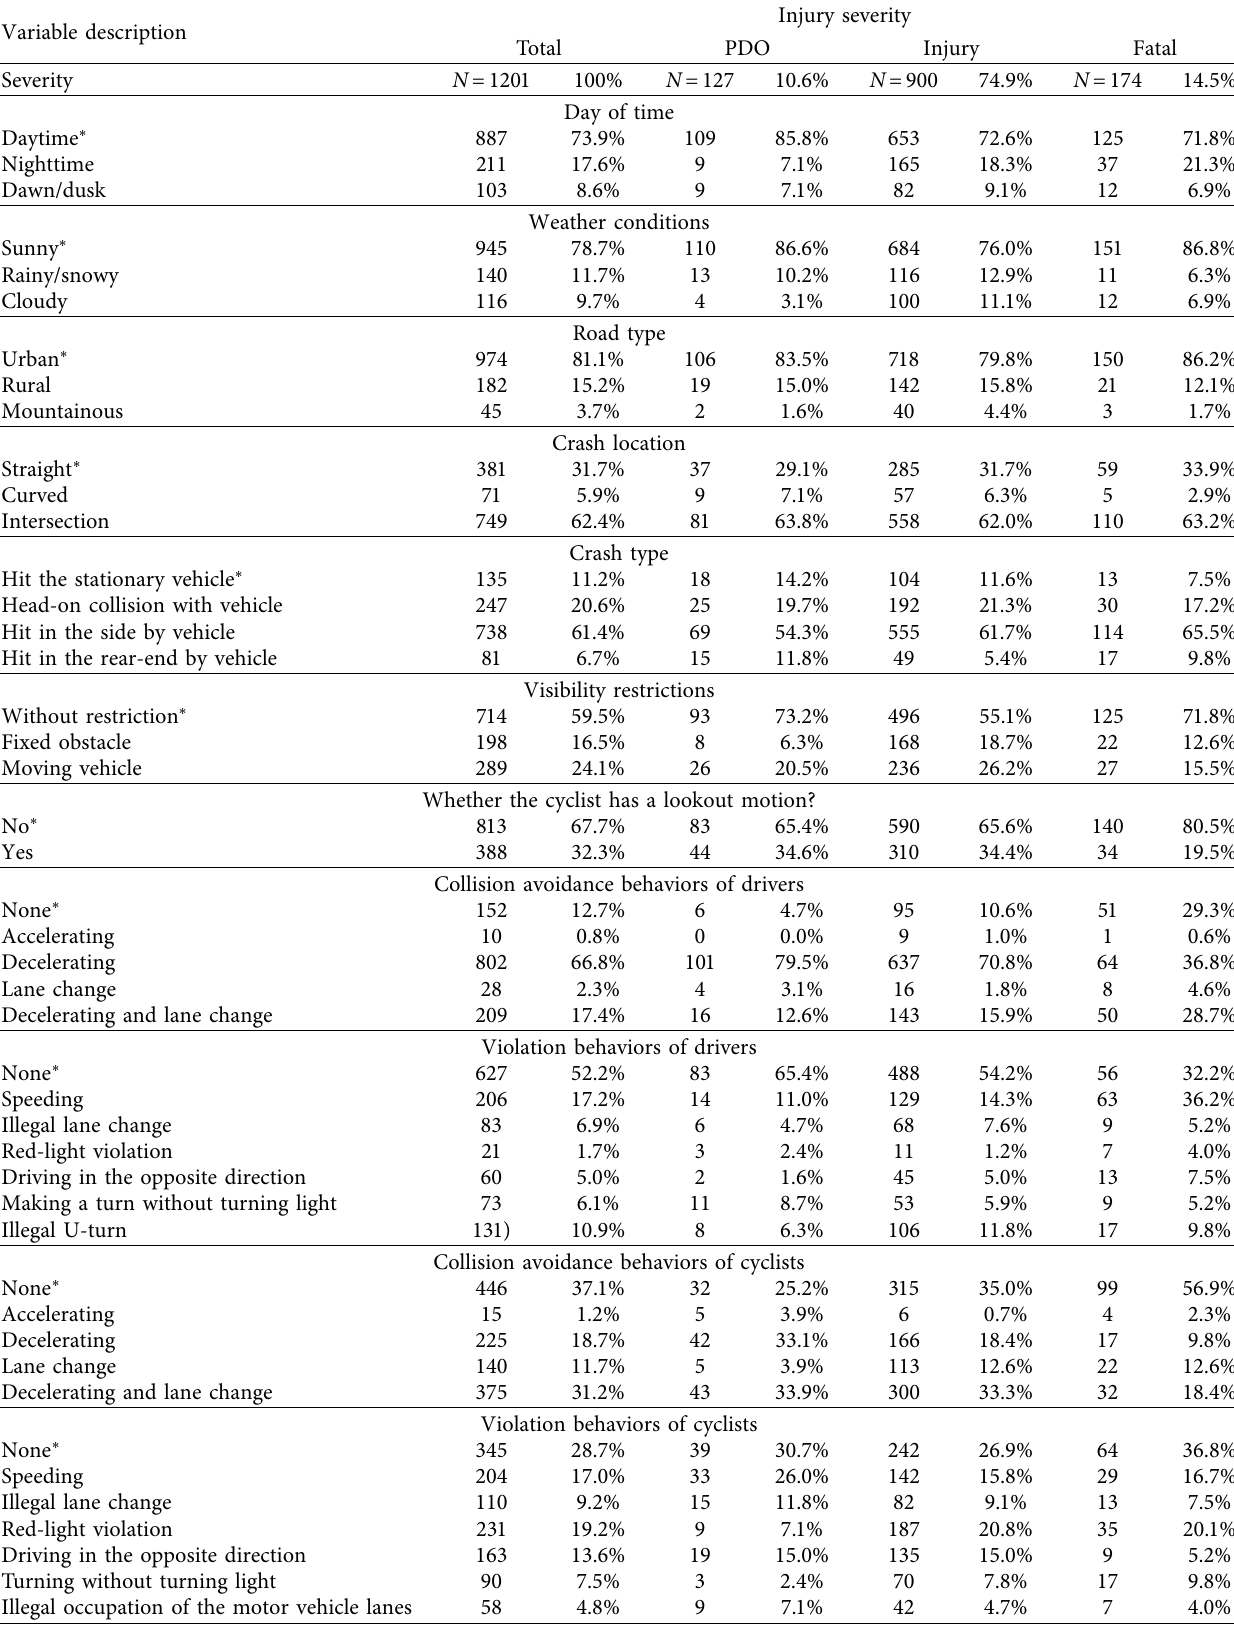
Table 1: Description of injury severity level frequency and percentage distribution by the explanatory